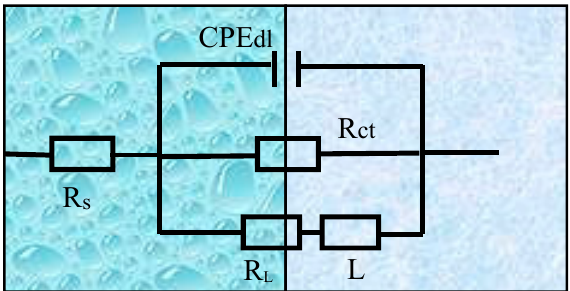
Figure 7. Equivalent circuit of electrochemical impedance spectroscopy (EIS) for extruded ZAT54x alloys.